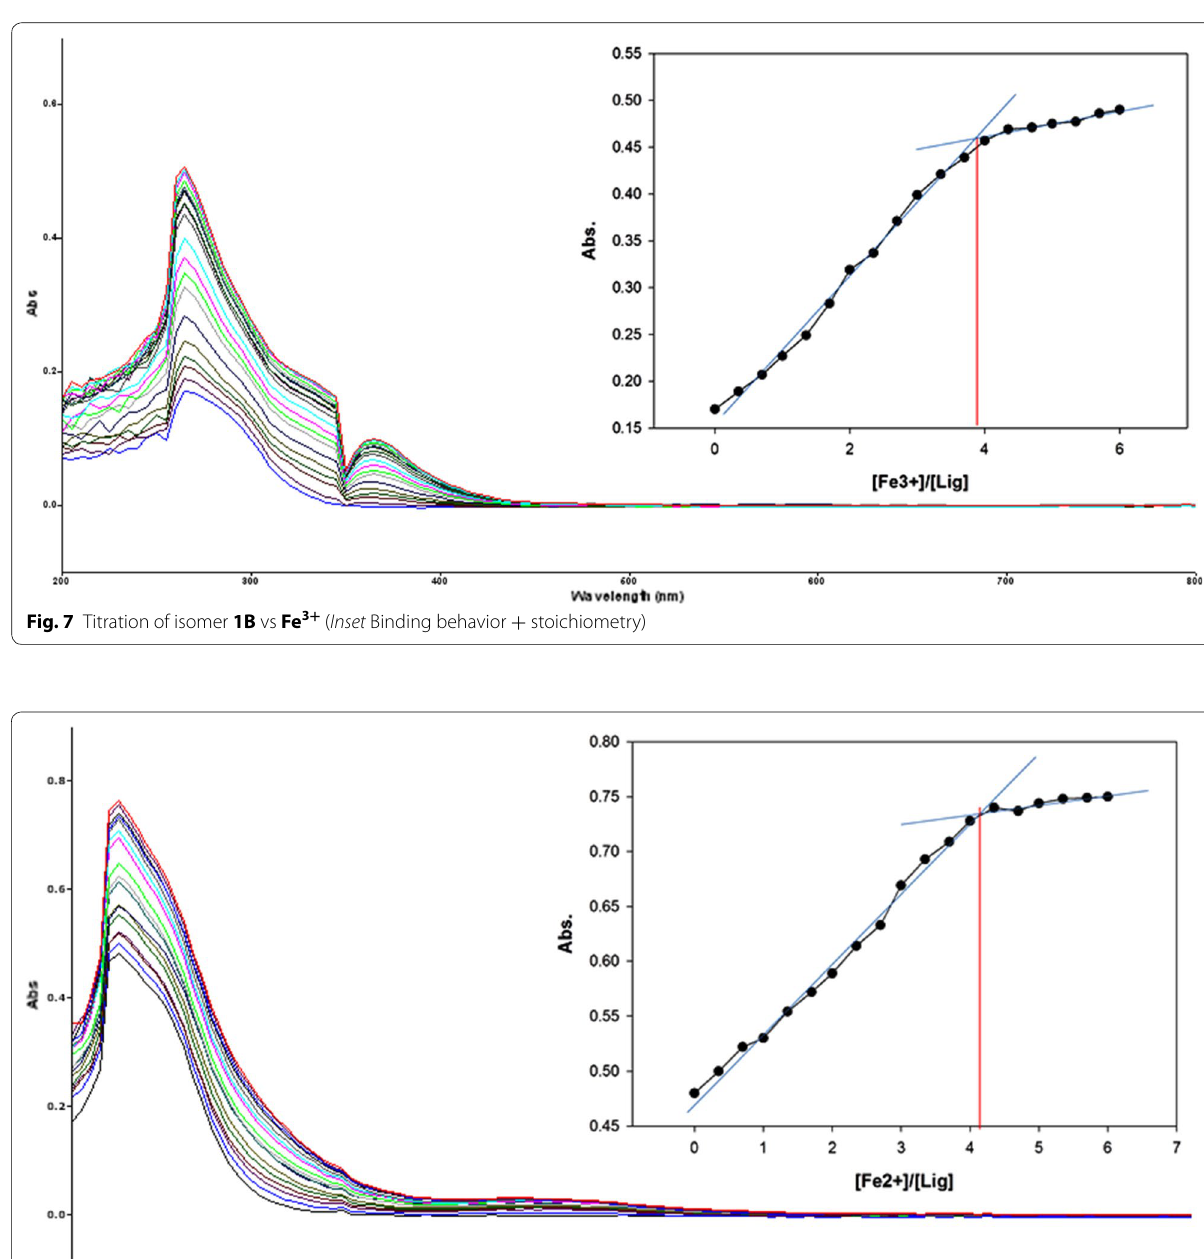
Fig. 8 Titration of isomer 1A vs Fe 2 + ( Inset Binding behavior